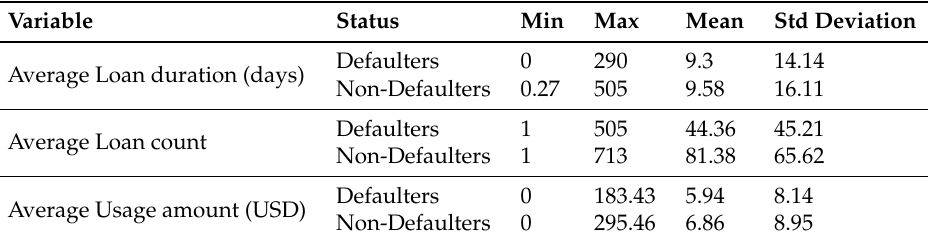
Table 4. Summary of feature